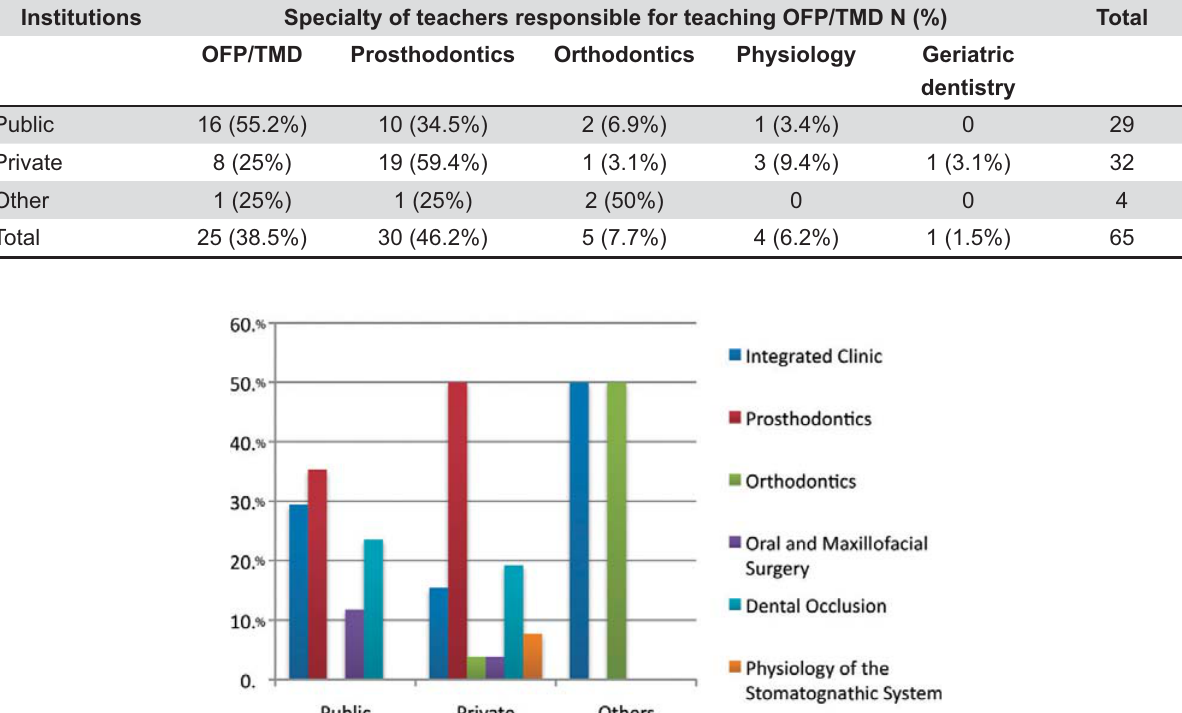
Table 4- Specialty of teachers responsible for teaching orofacial pain (OFP)/temporomandibular disorders